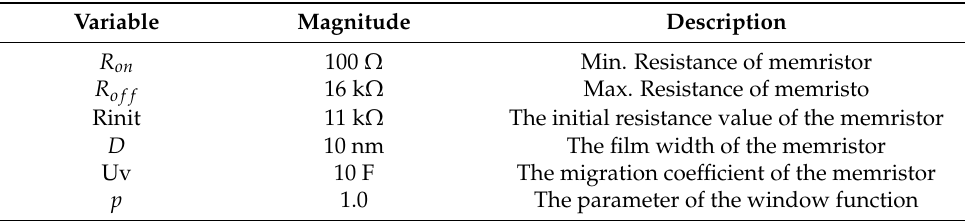
Figure 7. The model of memristor. Table 1. Memristor parameters setup.